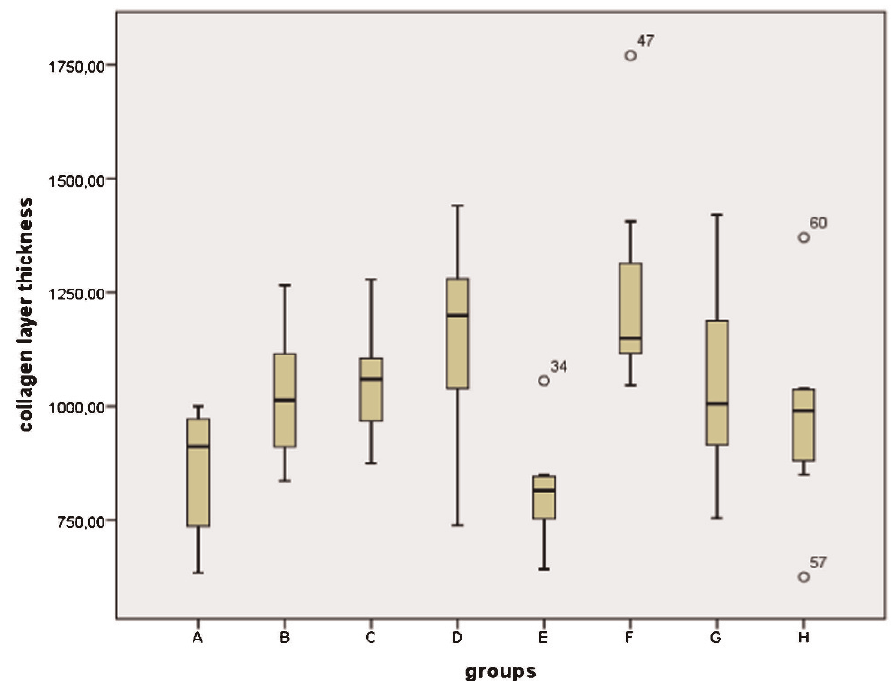
Figure 1 - The collagen layer thicknesses are presented in a box plot.